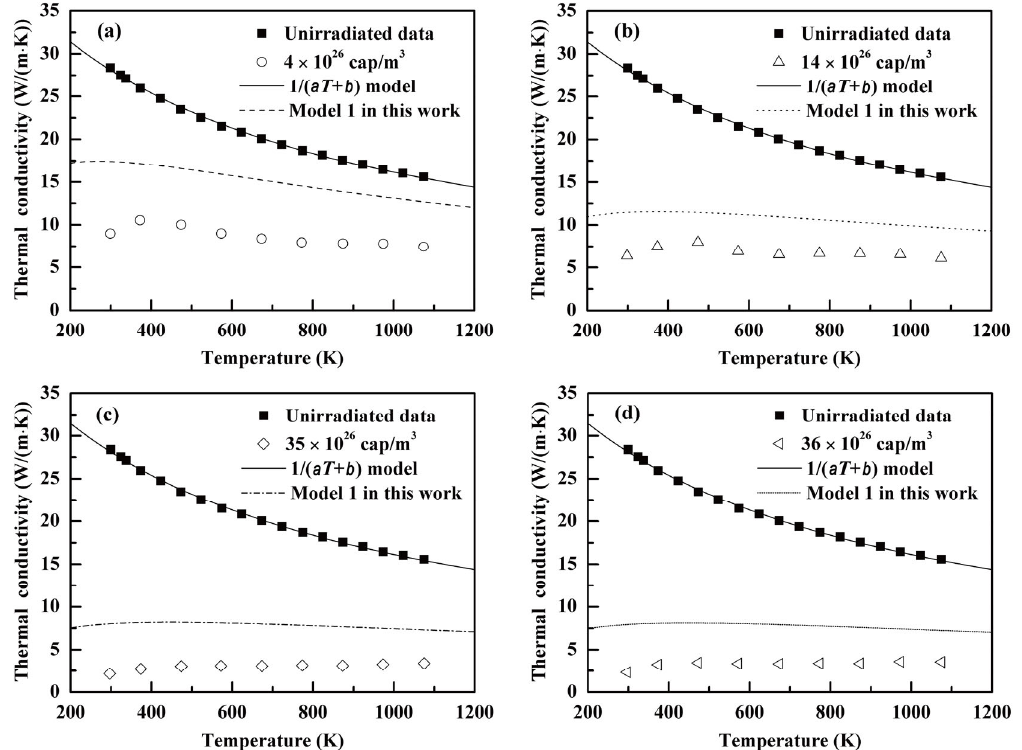
Fig. 2 Predicted thermal conductivities at different burnups by the model only considering the contribution of the substitutional defects (Model 1) with comparison to the experimental data of the samples before and after irradiation by Maruyama et al .